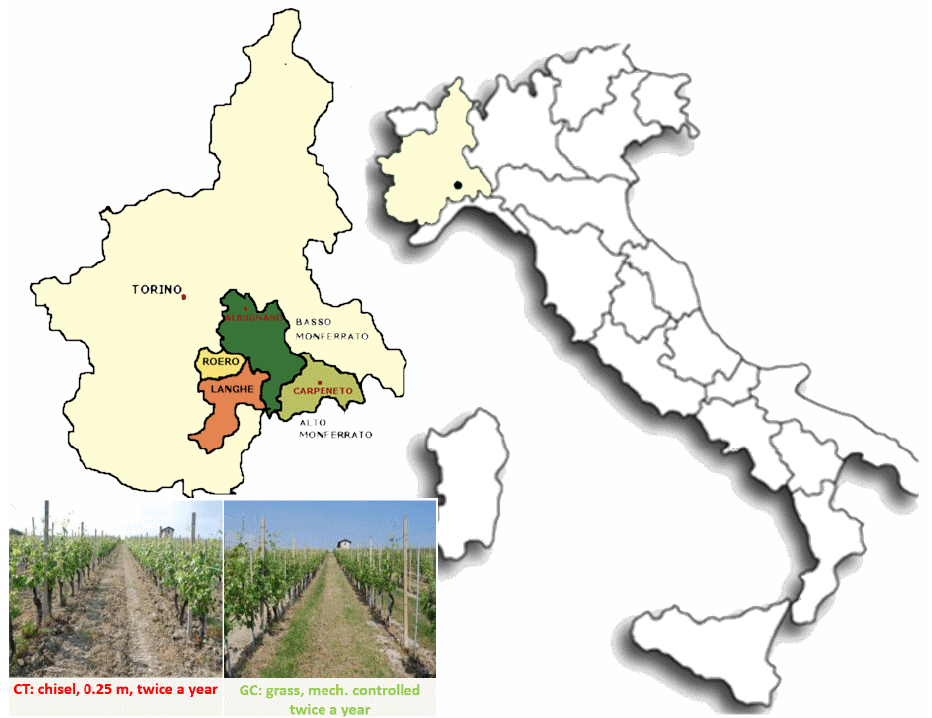
Figure 1. Location of the Tenuta Cannona Experimental Vine and Wine Centre of Agrion Foundation. Photos show the two soil managements.